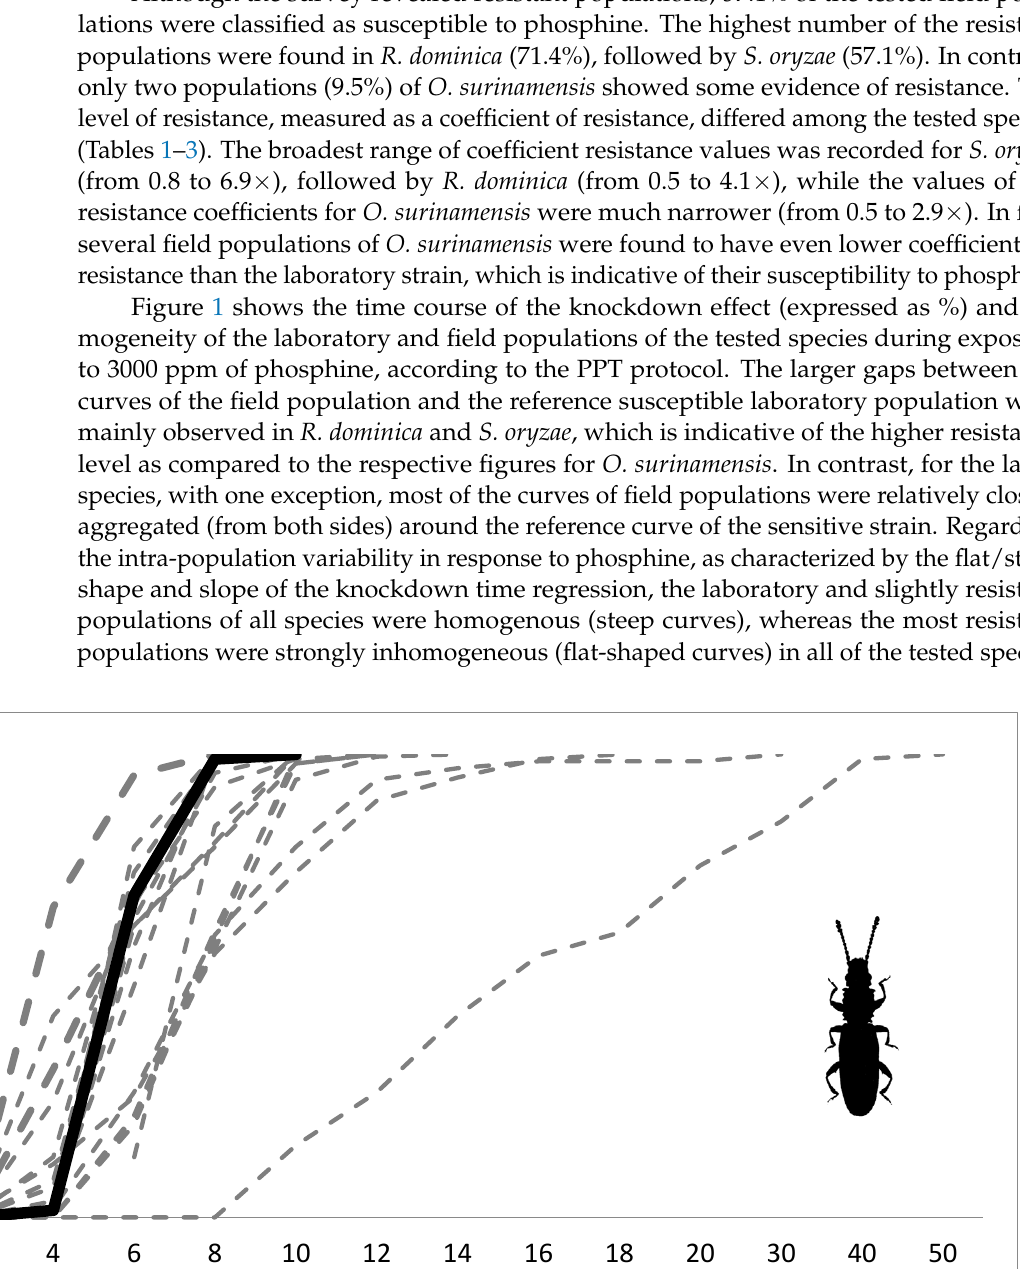
(Table 2: KT 100 -F = 636.8; df = 10; p < 0.001), and R. dominica (Table 3: KT 100 -F = 16.7; df = 6; p < 0.001).